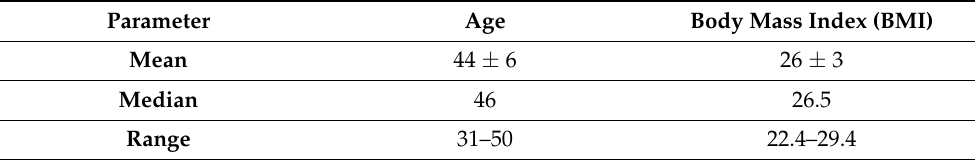
Table 3. Study demographics of the clinical Phase 1